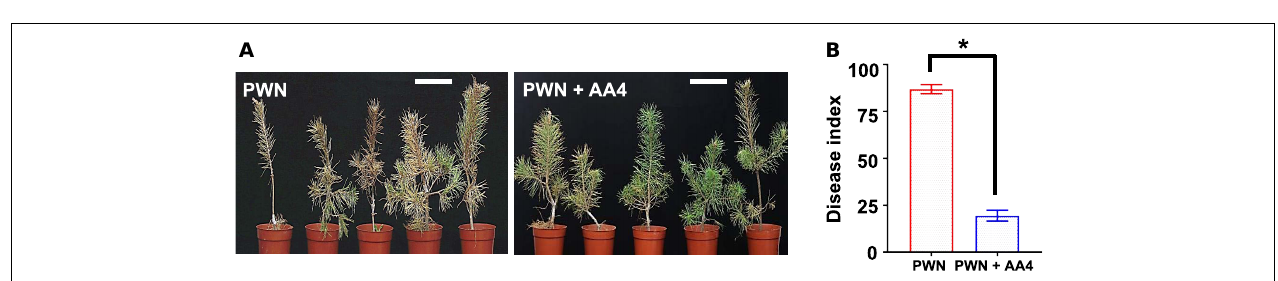
FIGURE 3 | Biocontrol effect of E. ludwigii AA4 against PWD caused by B. xylophilus . (A) Symptoms on the 3-year-old Pinus sylvestris seedlings inoculated with PWN alone or PWN jointly with E. ludwigii AA4 (PWN + AA4). Photographs were taken 30 days after inoculation (Scale bars: 15 cm). (B) Severity of PWD on the 3-year-old P. sylvestris seedlings inoculated with PWN alone and PWN jointly with E. ludwigii AA4 (PWN + AA4). The asterisk indicates that differences among the means represented by the columns are statistically significant (* p < 0.0001). Two-tailed t -test (GrapPad Prism 8) was used for the analysis.